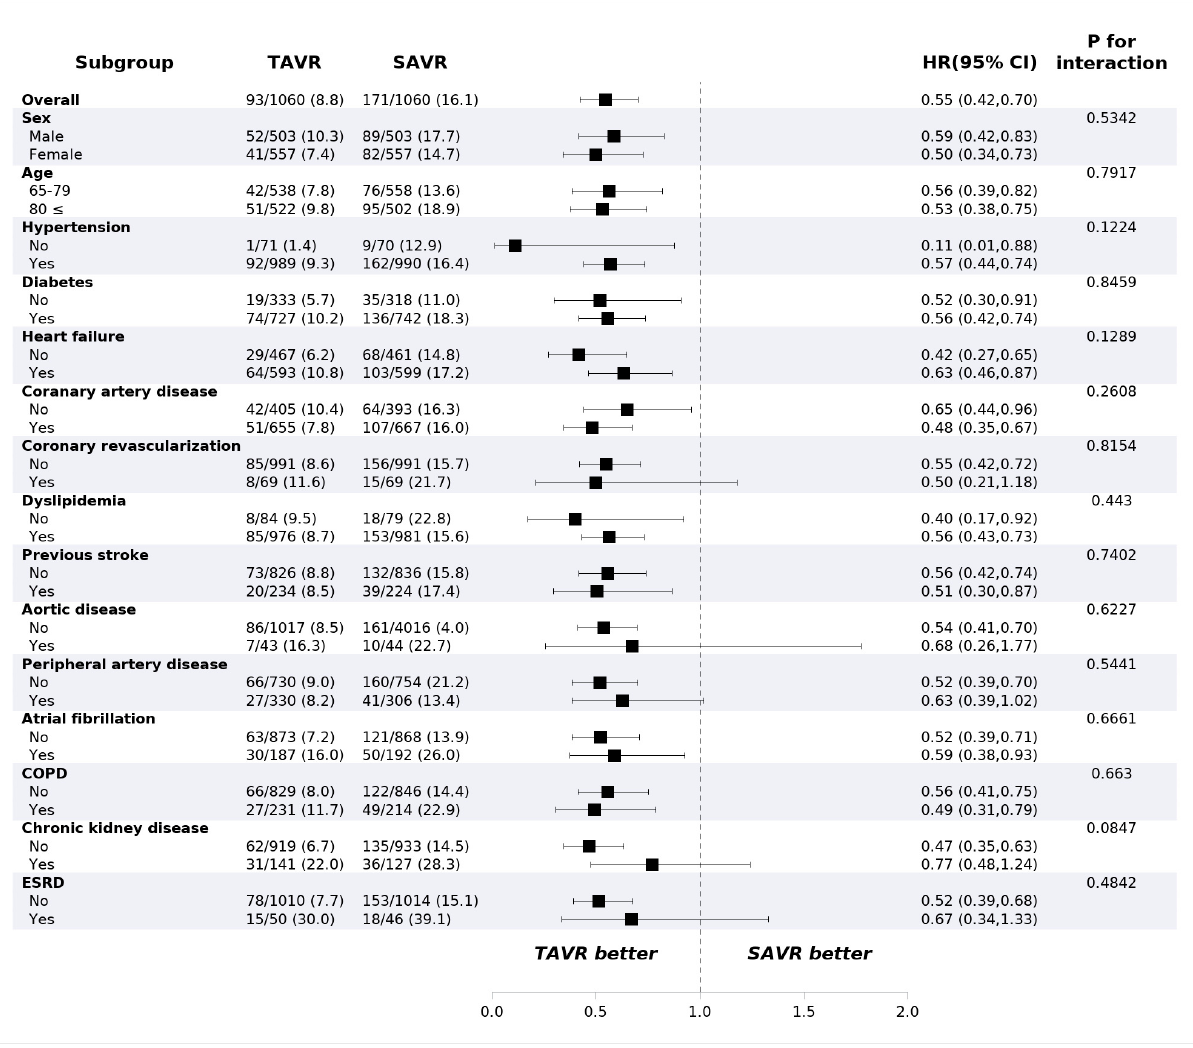
Figure 3. Mortality of subgroups in propensity-score-matched cohorts. Values are presented as number (%). CI: confidence interval; COPD: chronic obstructive pulmonary disease; ESRD: end- stage renal disease; HR: hazard ratio; SAVR: surgical aortic valve replacement; TAVR: transcatheter aortic valve replacement.